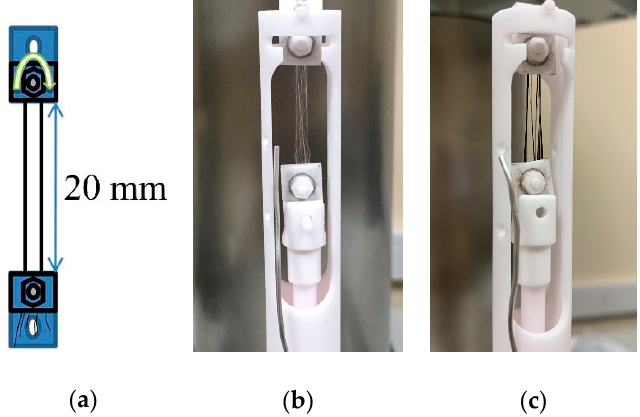
Figure 2. The pattern of fixing the sample in the clamps ( a ) and photographs of fibers fixed in the clamps (before ( b ) and after carbonization ( c )).